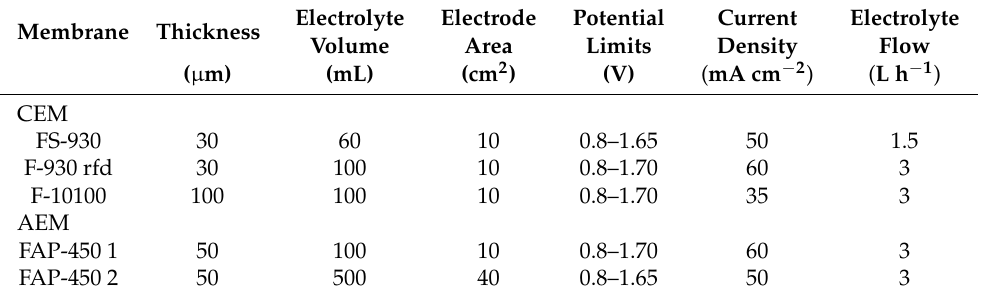
Table 1. Overview of the cation exchange membranes (CEM)/anion exchange membranes (AEM) and parameters used for